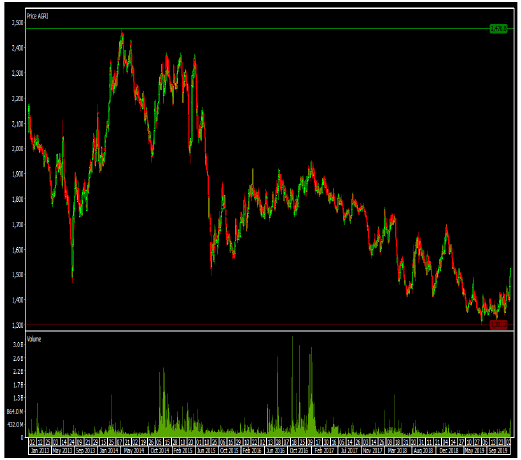
Fig. 1. Development of Agricultural Sector Index Prices Source: PT. Indopremier Sekuritas